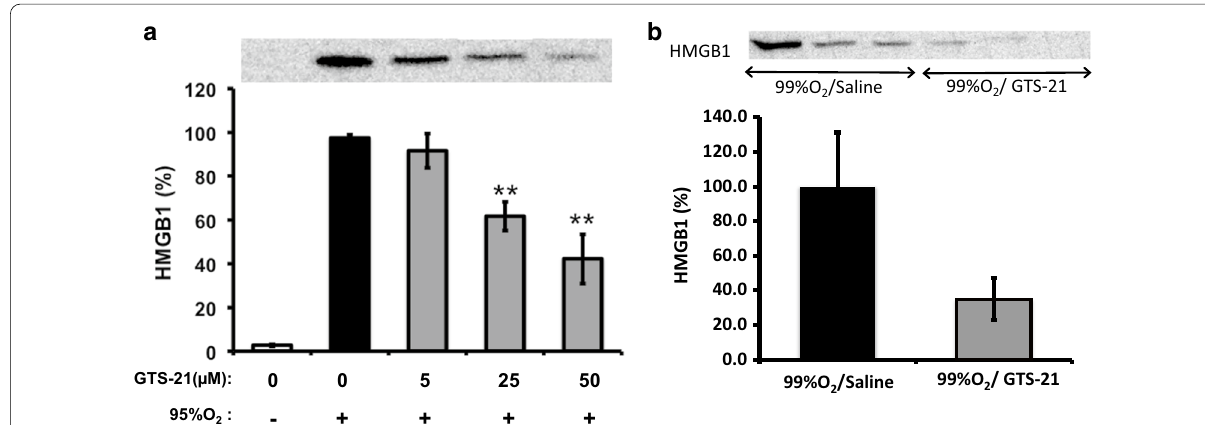
Fig. 3 GTS-21 inhibits the accumulation of extracellular HMGB1. a RAW 264.7 cells were either exposed to 95% O 2 alone (black bar) or 95% O 2 in the presence of a series of concentrations of GTS-21 (grey bars) or remained at 21% O 2 (white bar) for 24 h. HMGB1 levels in cell culture media were analyzed by Western blot analysis. Representative image of the immunoreactive bands on Western blots is shown. Bar graph shows the integrated density value of HMGB1 bands. The data are expressed as mean SEM of three independent experiments. **p < 0.01 versus control 95% O 2 alone ± (black bar). b C57BL/6 mice were exposed to 99% O 2 for 48 h and then inoculated with PA (0.1 10 8 CFUs/mouse), and returned to 21% O 2 ≥ × after inoculation. Mice were randomized to receive either GTS-21 or saline, administrated by intraperitoneal injection every 8 h, starting at 32 h during hyperoxia. Representative image of Western blot immunoreactive bands of HMGB1 in the BAL of these mice is shown. Bar graph shows the integrated density value of HMGB1 bands in BAL of mice that received saline (black bar, n 5) and GTS-21 (4 mg/kg, grey bar, n = =